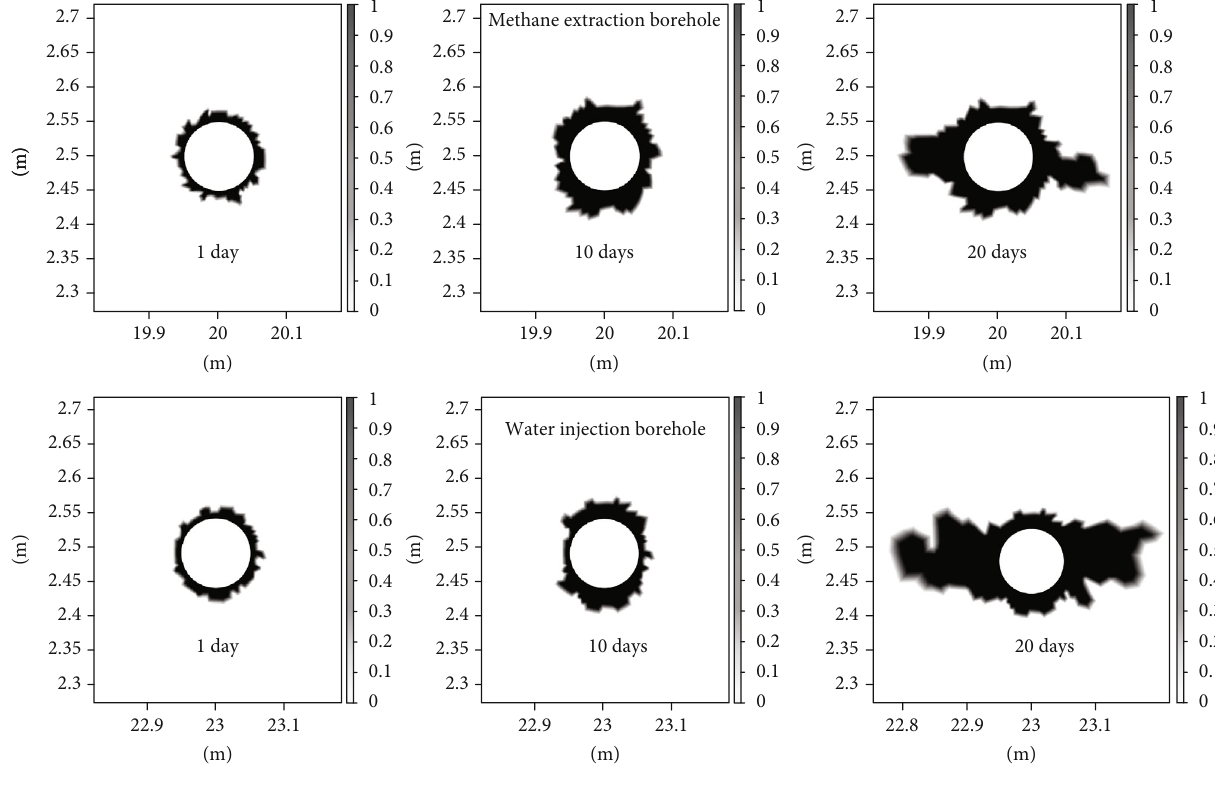
Figure 6: Damage zone near the boreholes.